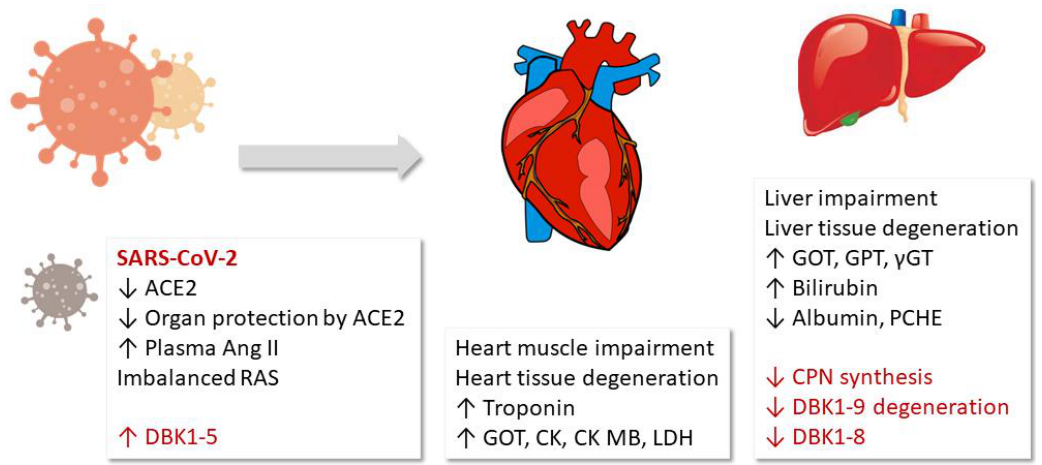
Figure 5. Results and hypothesis: Fragment DBK1-5 of labeled bradykinin (DBK) increased in severe COVID-19 cases due to enhanced angiotensin-converting enzyme (ACE) activity resulting from de- creased ACE2 counterbalance caused by the virus. The infection led to organ damage, and clinical parameters to that effect correlated with the neuropeptide reporter assay (NRA) results. The de- crease in both the serum DBK degradation and DBK1-8 formation capacity likely resulted from im- paired CPN synthesis in the liver. RAS: renin – angiotensin system, LDH: lactate dehydrogenase, ɣ GT: ɣ -glutamyltransferase, CK: creatine kinase, GOT: glutamate-oxalacetate transaminase, GPT: glutamate-pyruvate transaminase, PCHE: pseudocholinesterase. 5 . Conclusions Our study demonstrated the correlation of the activity of the serum proteases CPN and ACE with disease severity in COVID-19. CPN activity was reduced, which could be the result of the impaired liver function observed in the disease. Increased ACE activity was detected in fatally ill patients and indicated dysregulation of the RAS. The observa- tion that none of the hospitalized patients taking ACEI or ARB died in contrast to half of the untreated hypertonic patients supported the notion that ACE might be a therapeutic target. Biswas and Kali [8] argued in their study that the reduction of deaths compared to COVID-19 patients not treated with ACEIs/ARBs could be associated with the organo- protective nature of upregulated ACE2 induced by the medication. It is worthwhile to test this hypothesis in further experimental studies as the well established hypertonia treat- ment would be a straightforward approach to alleviate some of the symptoms of COVID- 19 infection. This study provided evidence that ACEI/ARB medication does not enhance COVID-19 symptoms as discussed in the public for some time, but that it may be, in con- trast, protective. Supplementary Materials: The following are available online at www.mdpi.com/xxx/s1, Supple- ment: Table S1 : ACE2 and viral infection (assembled from [5,8,9] and references therein), Table S2: ACE/ACE2-related factors relevant in COVID-19 progression (assembled from [5,8,9] and references therein). Author Contributions: Conceptualization, P.-R.T. and S.K.; data curation, R.V. and S.K.; formal analysis, R.V., N.S. and S.K.; funding acquisition, P.-R.T. and S.K.; investigation, R.V. and S.K.; meth- odology, R.V., N.S. and S.K.; project administration, P.-R.T. and S.K.; resources, P.-R.T. and S.K.; supervision, P.-R.T. and S.K.; validation, R.V., N.S. and S.K.; writing — original draft, P.-R.T. and S.K.; writing — review and editing, P.-R.T., R.V. and S.K. All authors have read and agreed to the published version of the manuscript.